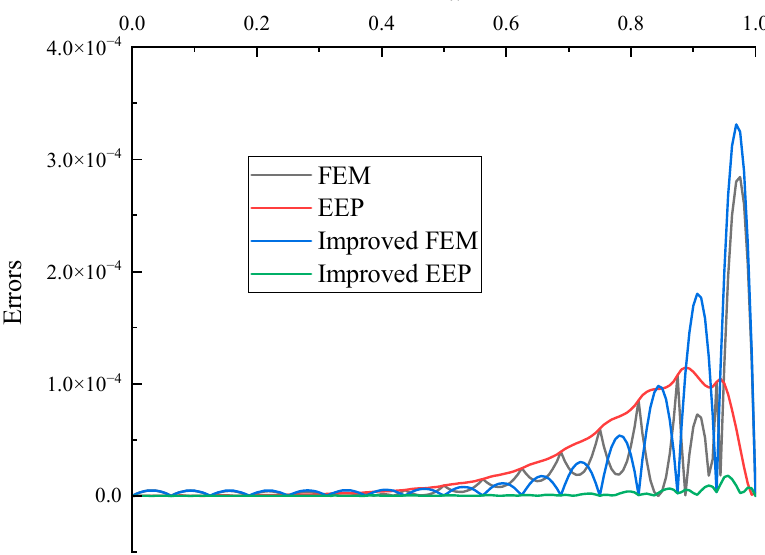
Figure 7. Error distributions.